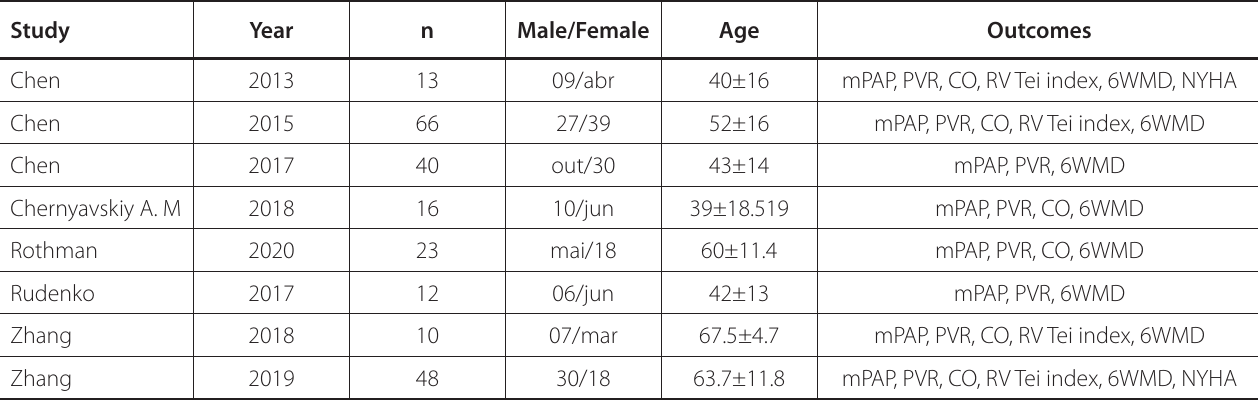
Table 1. Baseline characteristics of included trials.